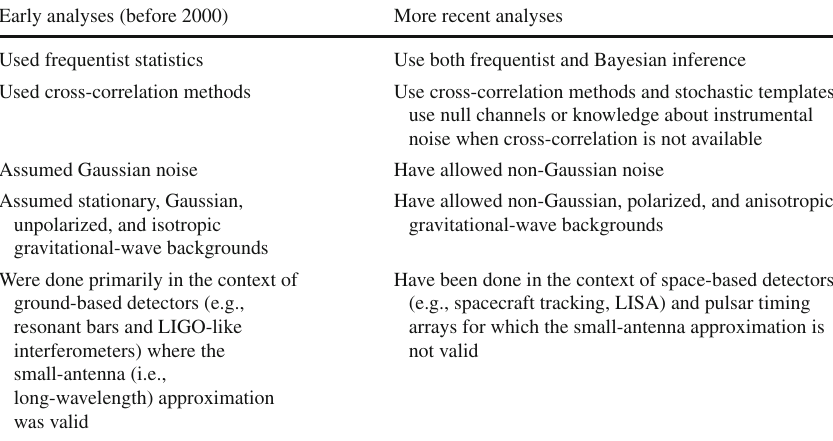
Table 1 Overview of analysis methods for stochastic gravitational-wave backgrounds Early analyses (before 2000) More recent analyses Used frequentist statistics Use both frequentist and Bayesian inference Used cross-correlation